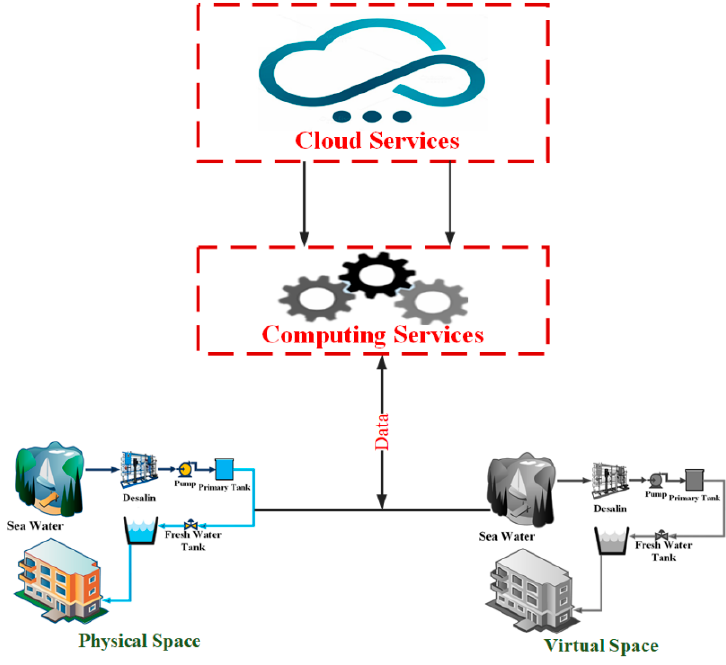
Figure 1. Illustration of a digital twin structure.